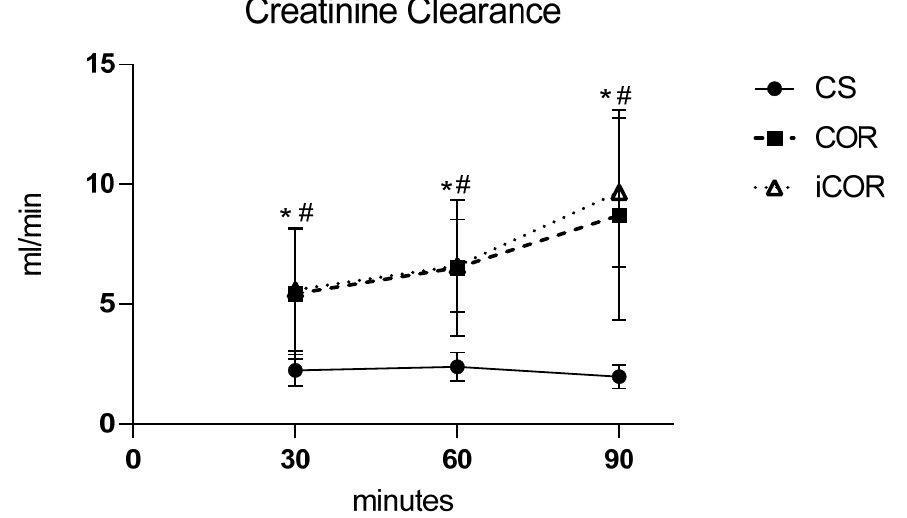
Figure 2. Clearance of creatinine during reperfusion in vitro after 20 h cold storage (CS) or after 2 h of subsequent controlled oxygenated rewarming with (COR) or without (iCOR) an initial hypothermic perfusion period (*: p < 0.05 COR vs. CS; #: p < 0.05 iCOR vs. CS). Likewise, urinary leakage of albumin (expressed as the albumin/creatinine ratio) was markedly increased to 0.40 ± 0.14 in cold-stored kidneys but significantly ( p < 0.05) reduced after COR (0.13 ± 0.05), as well as after iCOR treatment (0.12 ± 0.03) prior to reperfusion.